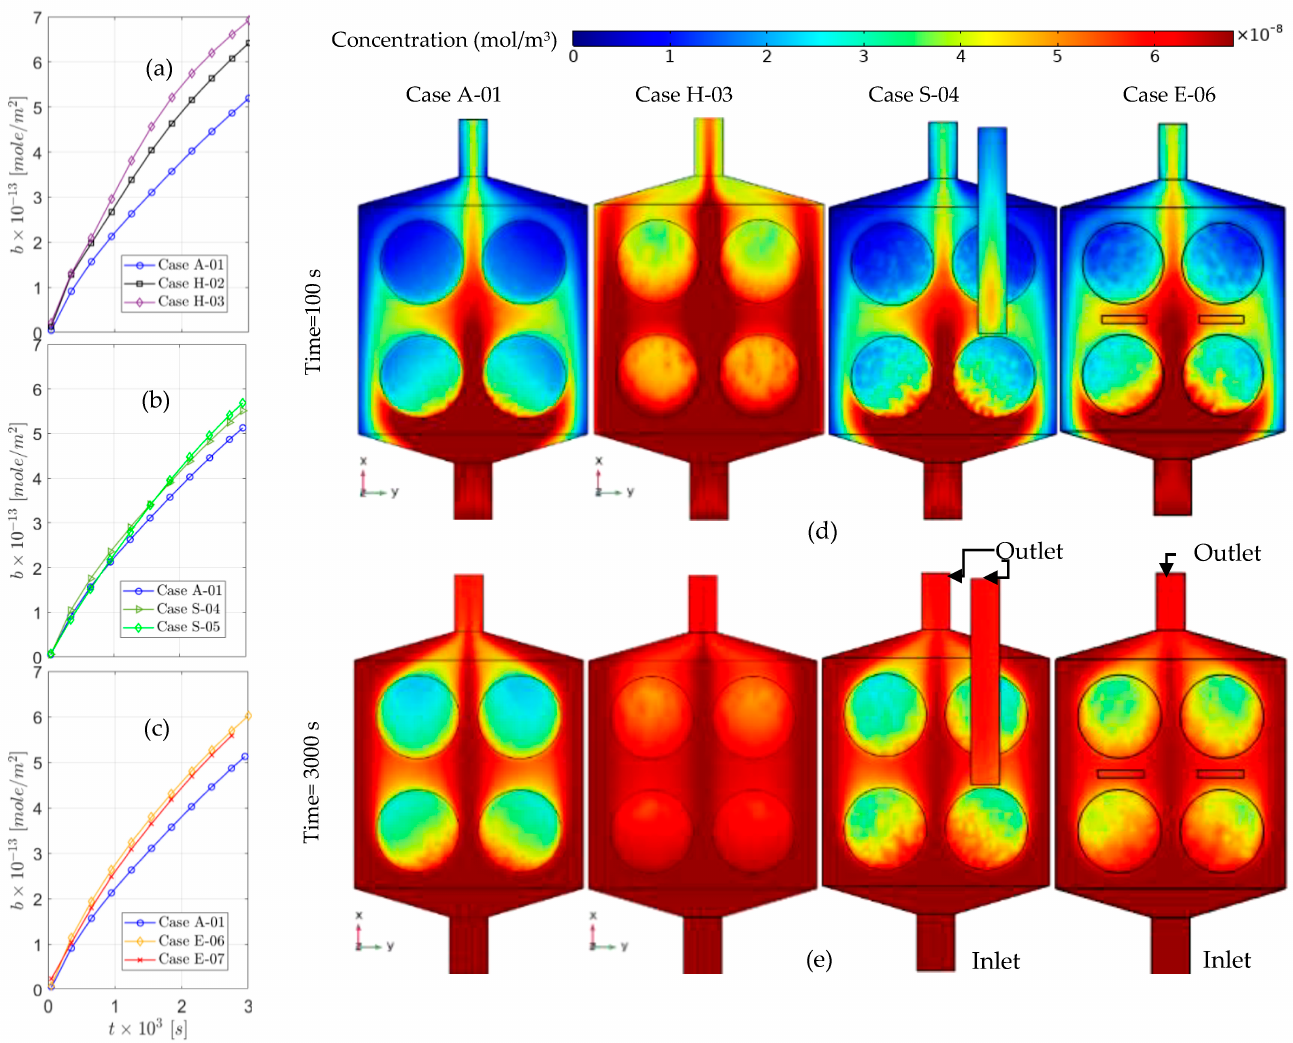
Figure 5. The time-dependent solution for surface concentration in the first 50 min for the original experimental setup (Case A) in comparison to the: thin chamber ( a ), suction ( b ), and electroosmotic flow ( c ). A slide of bulk concentration on the functionalized surfaces for cases A-01, H-03, S-04, and E06, after 100 𝑠 ( d ) and 3000 𝑠 ( e ).